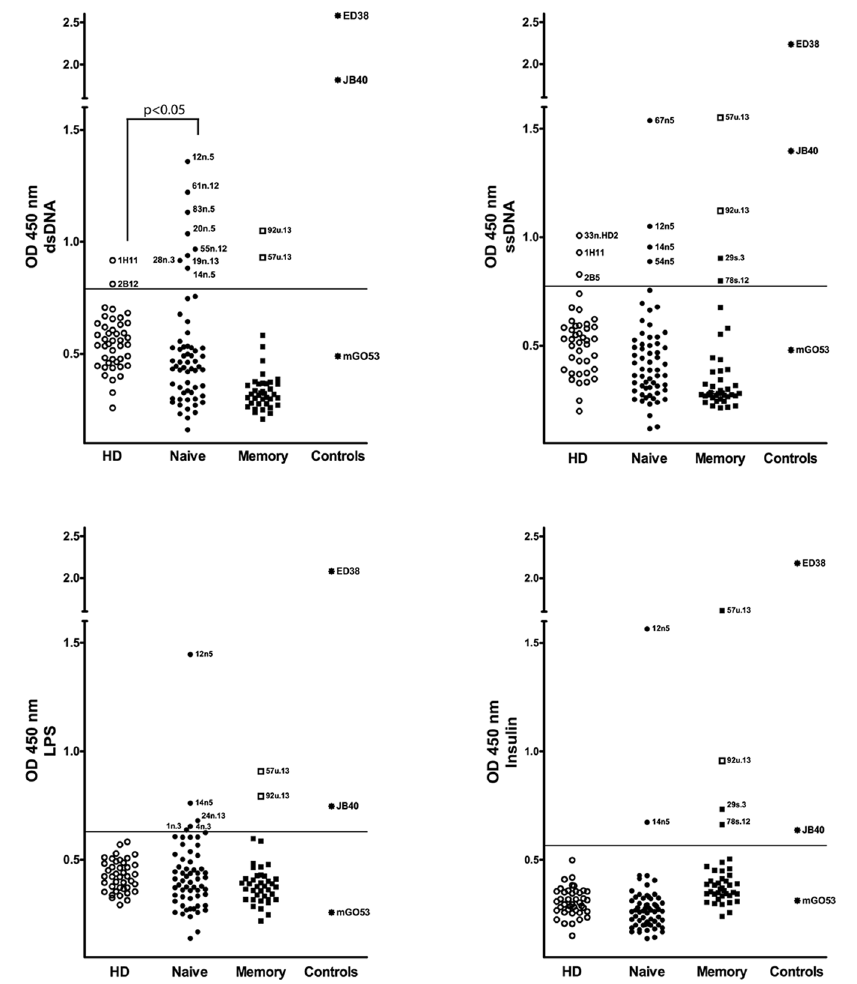
Fig. 5. Polyreactivity of naı¨ve and memory B cell antibodies from SS patients and HD. Naı¨ve B cell antibodies from SS patients (n 5 60), HD (n 5 41) and memory B cells from SS patients (n 5 39) were tested for reactivity with dsDNA (top left), ssDNA (top right), LPS (bottom left) and insulin (bottom right) by ELISA. Each graph shows the reactivity at a concentration of 1 m g/ml and it shows the result of two independent experiments. The cut-off OD (450 nm) at which antibodies were considered reactive is shown by the horizontal lines. Data points represent individual antibodies. Internal controls for polyreactivity (star dots) are shown in each graph and include mGO53 (negative; [ 17]), JB40 (low polyreactive; [17]), and ED38 (highly polyreactive;